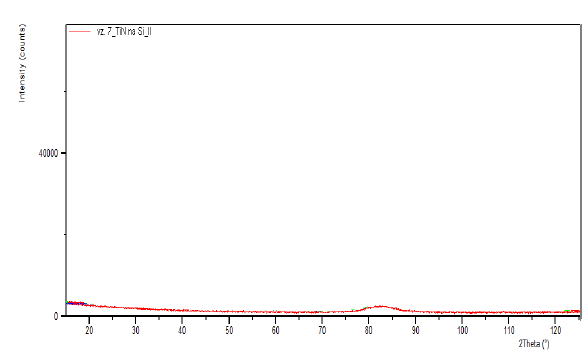
Figure 4. Raman spectra of samples K7 and K9. Figure 5. XRD patterns obtained with sample K7